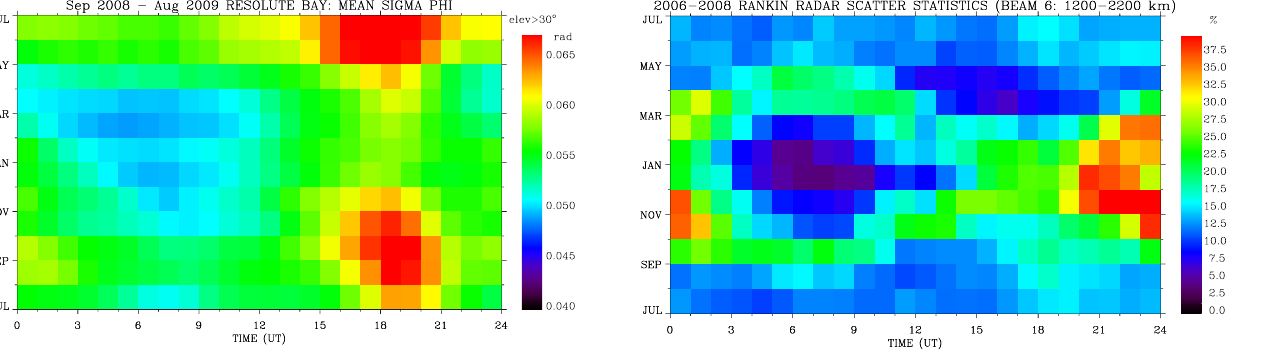
Fig. 9. The F-region backscatter statistics for the Rankin Inlet radar beam 6. Magnetic local midnight and noon for a point midway between Resolute Bay and Eureka (mid-beam 6) at altitude 350km are approximately at 06:50 and 19:20UT,